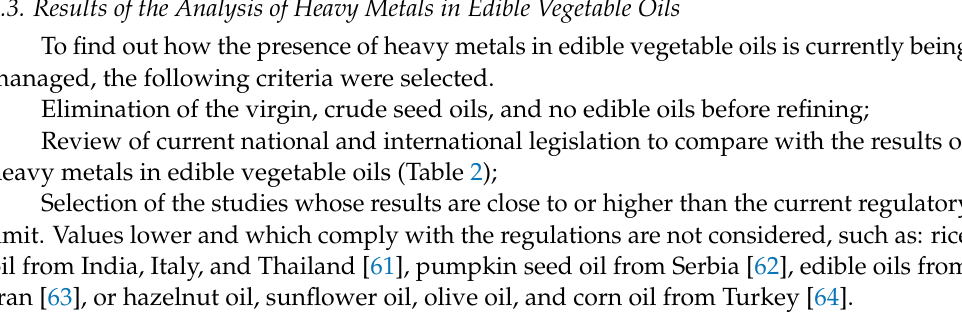
Table 2. Toxicity thresholds established in current national and international legislation for heavy metals, expressed in